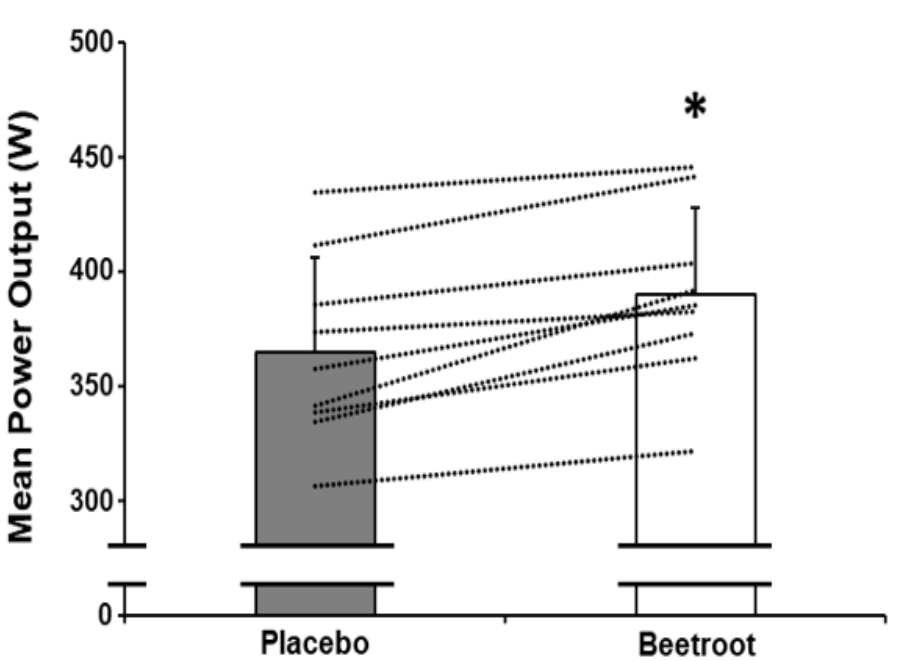
Figure 1. Mean power output between 30 – 60 s of a maximal 60 s end-sprint following 2 h moderate- intensity exercise after ingestion of nitrate-depleted beetroot (placebo, grey bar) and nitrate-rich beetroot (beetroot, open bar) powder. Dashed lines represent individual responses. Data presented as mean ± SD. * indicates significantly higher than placebo ( p < 0.001).